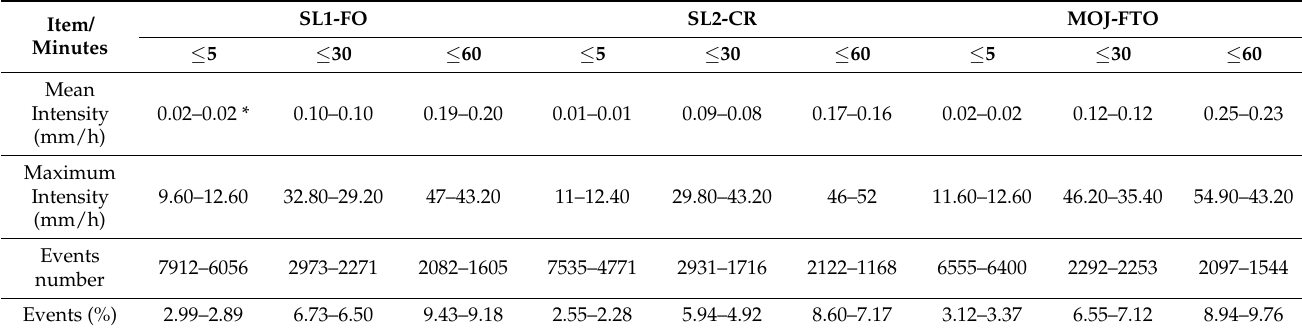
Table 4. Frequency and distribution of the precipitation for studied